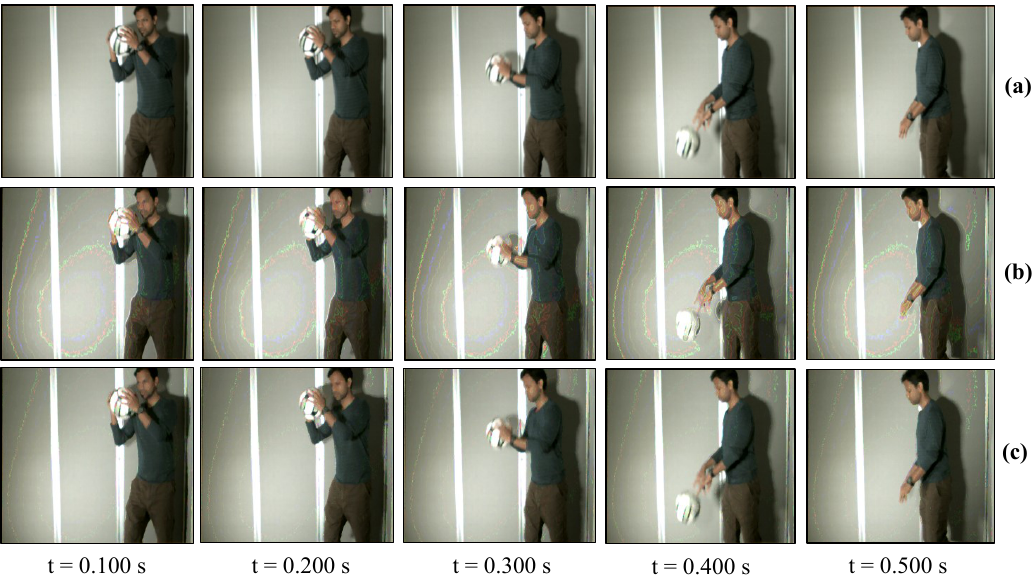
Figure 18. Reconstructed USB camera input image sequence on the plain background: ( a ) 640 × 480 input image; ( b ) 510 × 459 binary-code image without background subtraction; and ( c ) 510 × 459 binary-code image with background